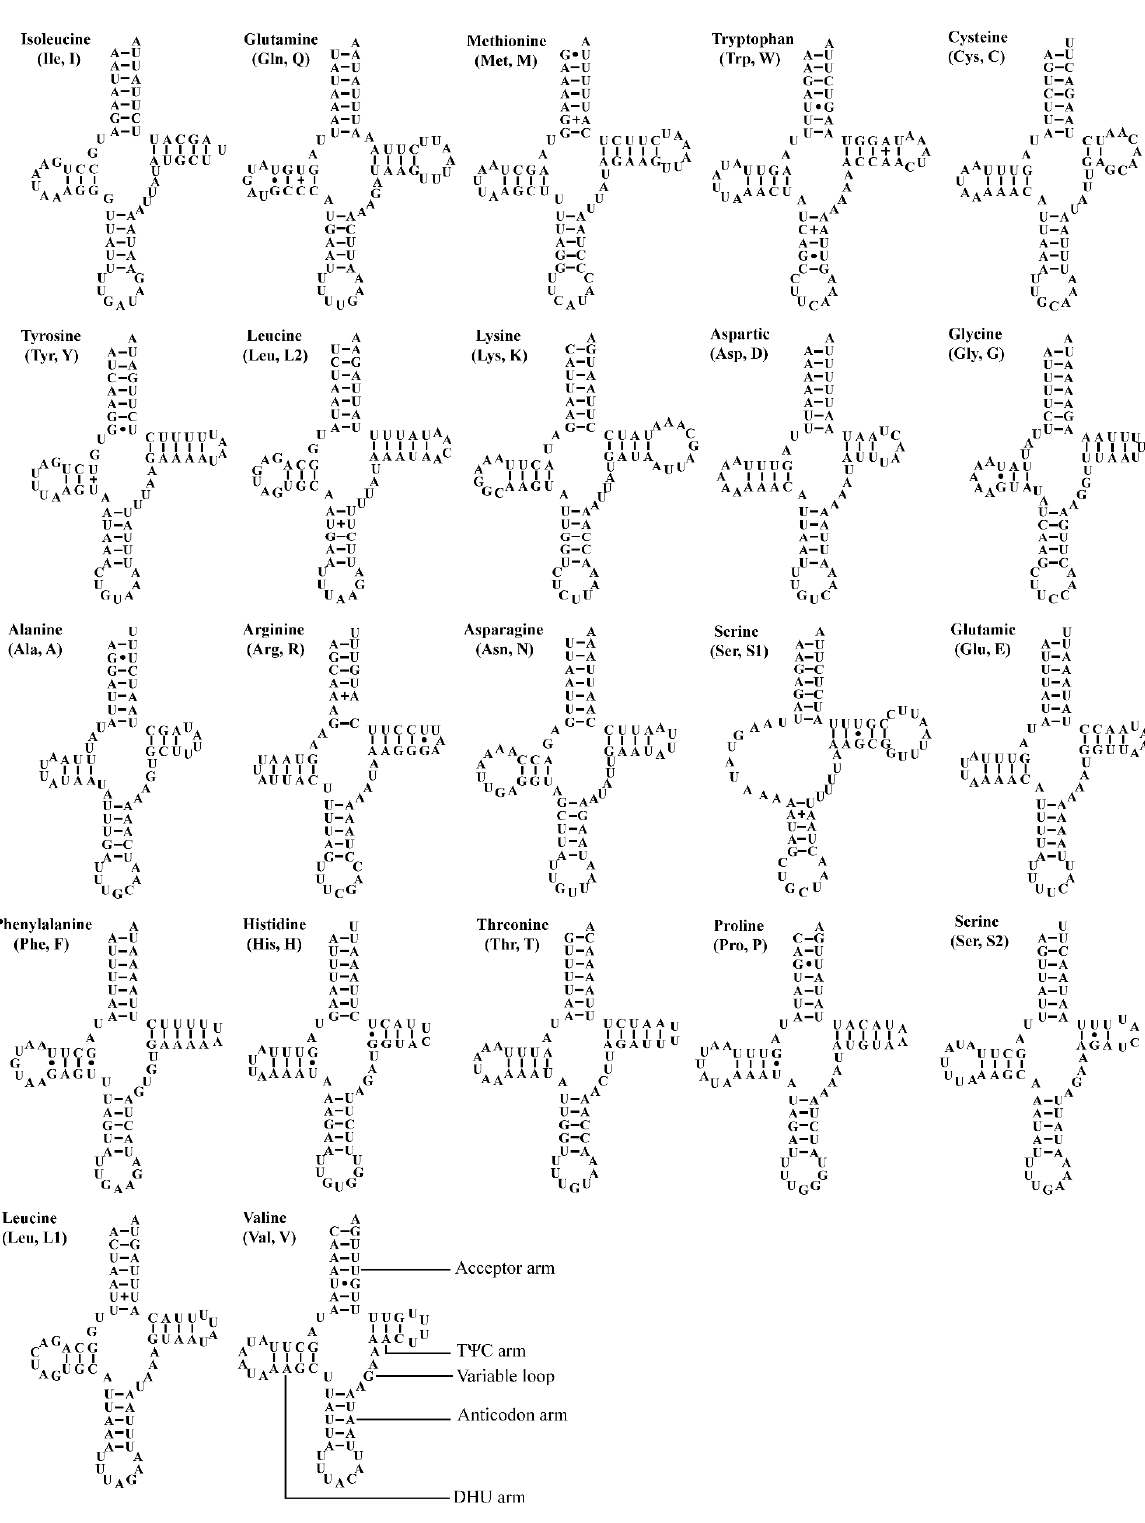
Figure 5. Predicted secondary cloverleaf structure for the tRNAs of Atkinsoniella xanthonota . The tRNA arms are illustrated as for trnV. Dashes (–), solid dots (•), and pluses (+) indicate the Watson–Crick base pairings, G–U bonds, and mismatches, respectively.